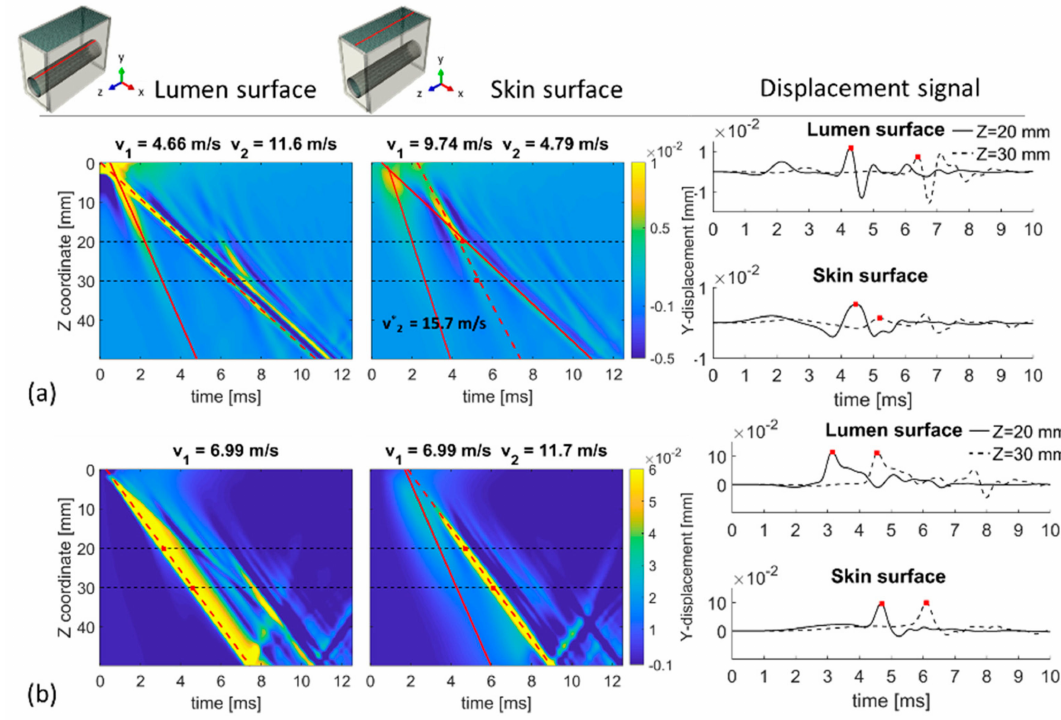
Figure 5. Time-of-flight (TOF) plots of the out-of-plane displacements at the lumen and skin surface for ( a ) shock impulse and ( b ) traveling load (V z of 7 m / s). The propagation velocity of the main wave front (V 1 ) corresponds to the slope of the red dashed line and the speeds of potential secondary wave fronts (V 2 and V * 2 ) are indicated by the slopes of the solid lines on the TOF